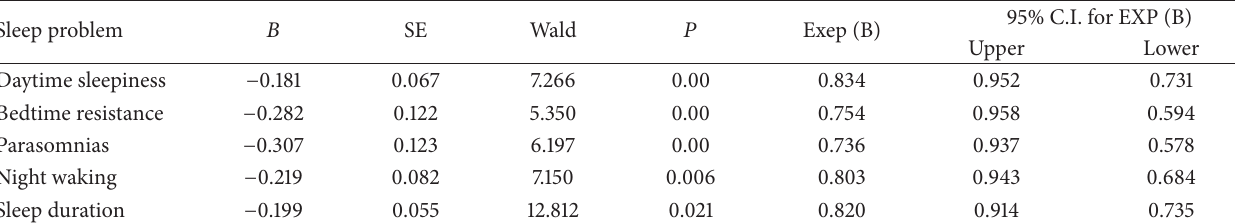
Table 2: Association of accidental injuries with sleep problem: multivariate logistic